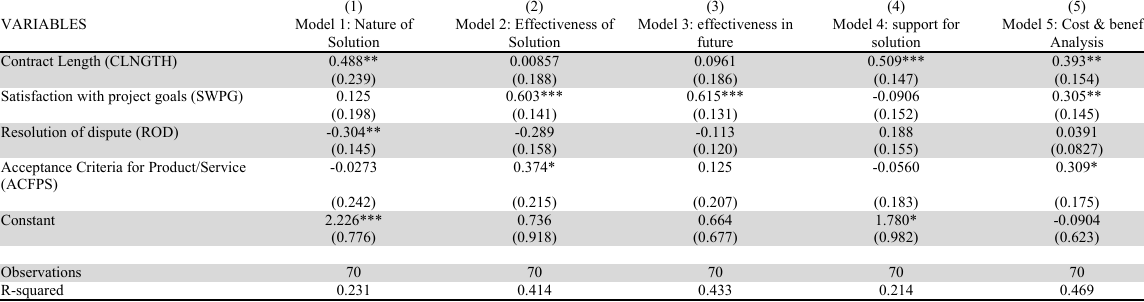
Model 2: Effectiveness of Model 3: effectiveness in Model 4: support for Model 5: Cost & benefit Solution future solution